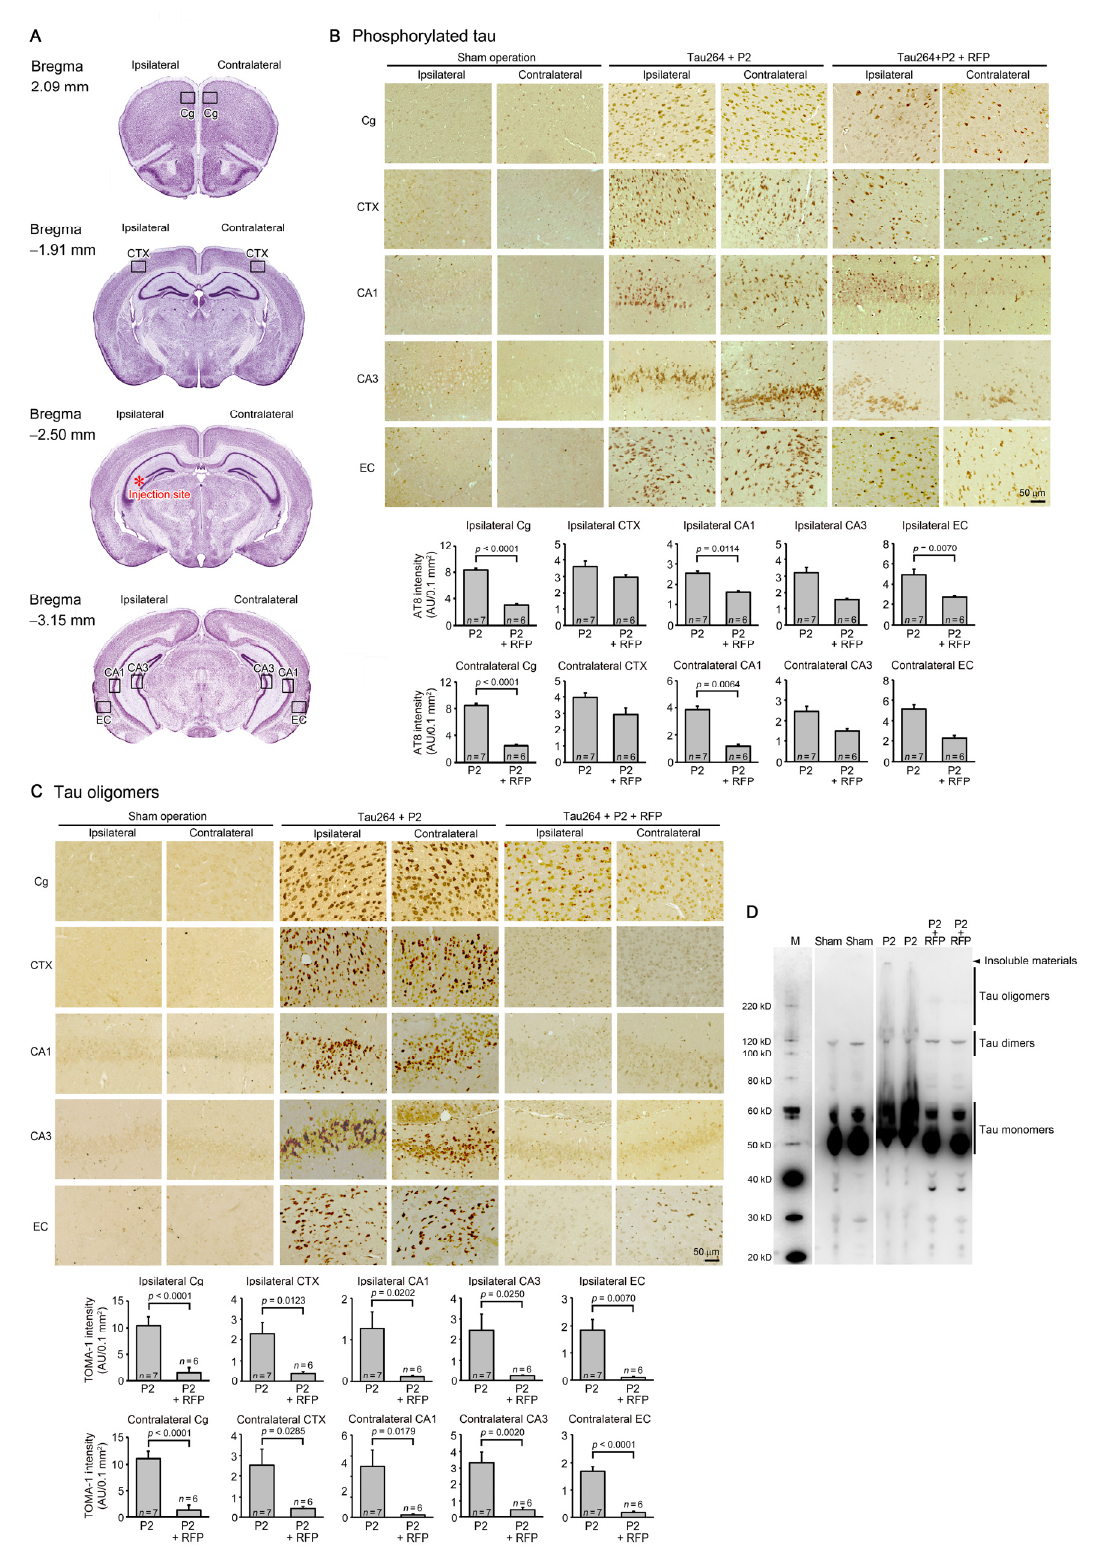
Figure 2. Intracerebral spreading of phosphorylated and oligomeric tau species and the effects of rifampicin treatment. ( A ) After 24 weeks of rifampicin treatment, brain sections anterior and posterior to the injection site were examined for the spreading of tau pathology. Cg, cingulate cortex; CTX, cerebral cortex; CA1 and CA3, hippocampal CA1 and CA3 regions; EC, entorhinal cortex. ( B ) In